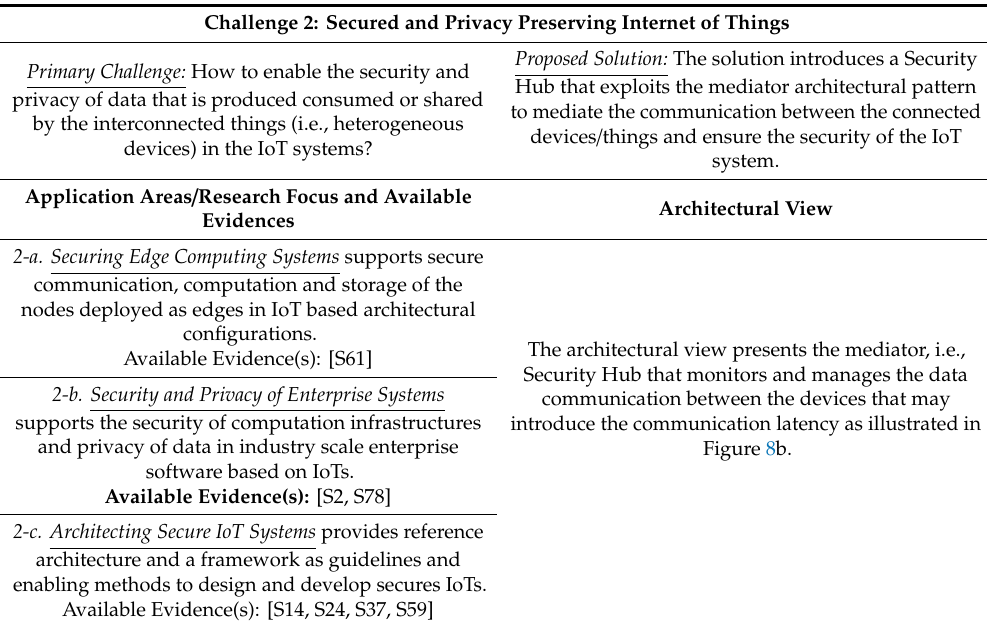
Table 6. Challenge II— Overview of the challenges and architectural solutions for secured and privacy preserving IoTs.